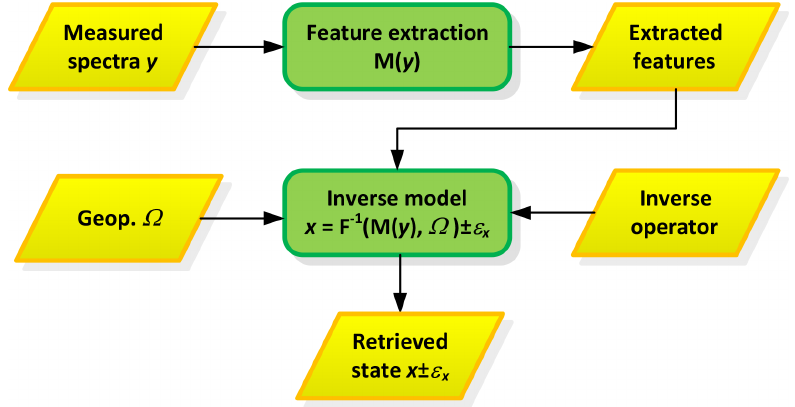
Figure 2. Data flow diagram for the FP_ILM retrieval phase. The inverse operator computed during the FP_ILM training phase solves the inverse problem and retrieves the state vector x , taking as input the features M(y) extracted from the measured spectra y and geophysical conditions (cid:127)